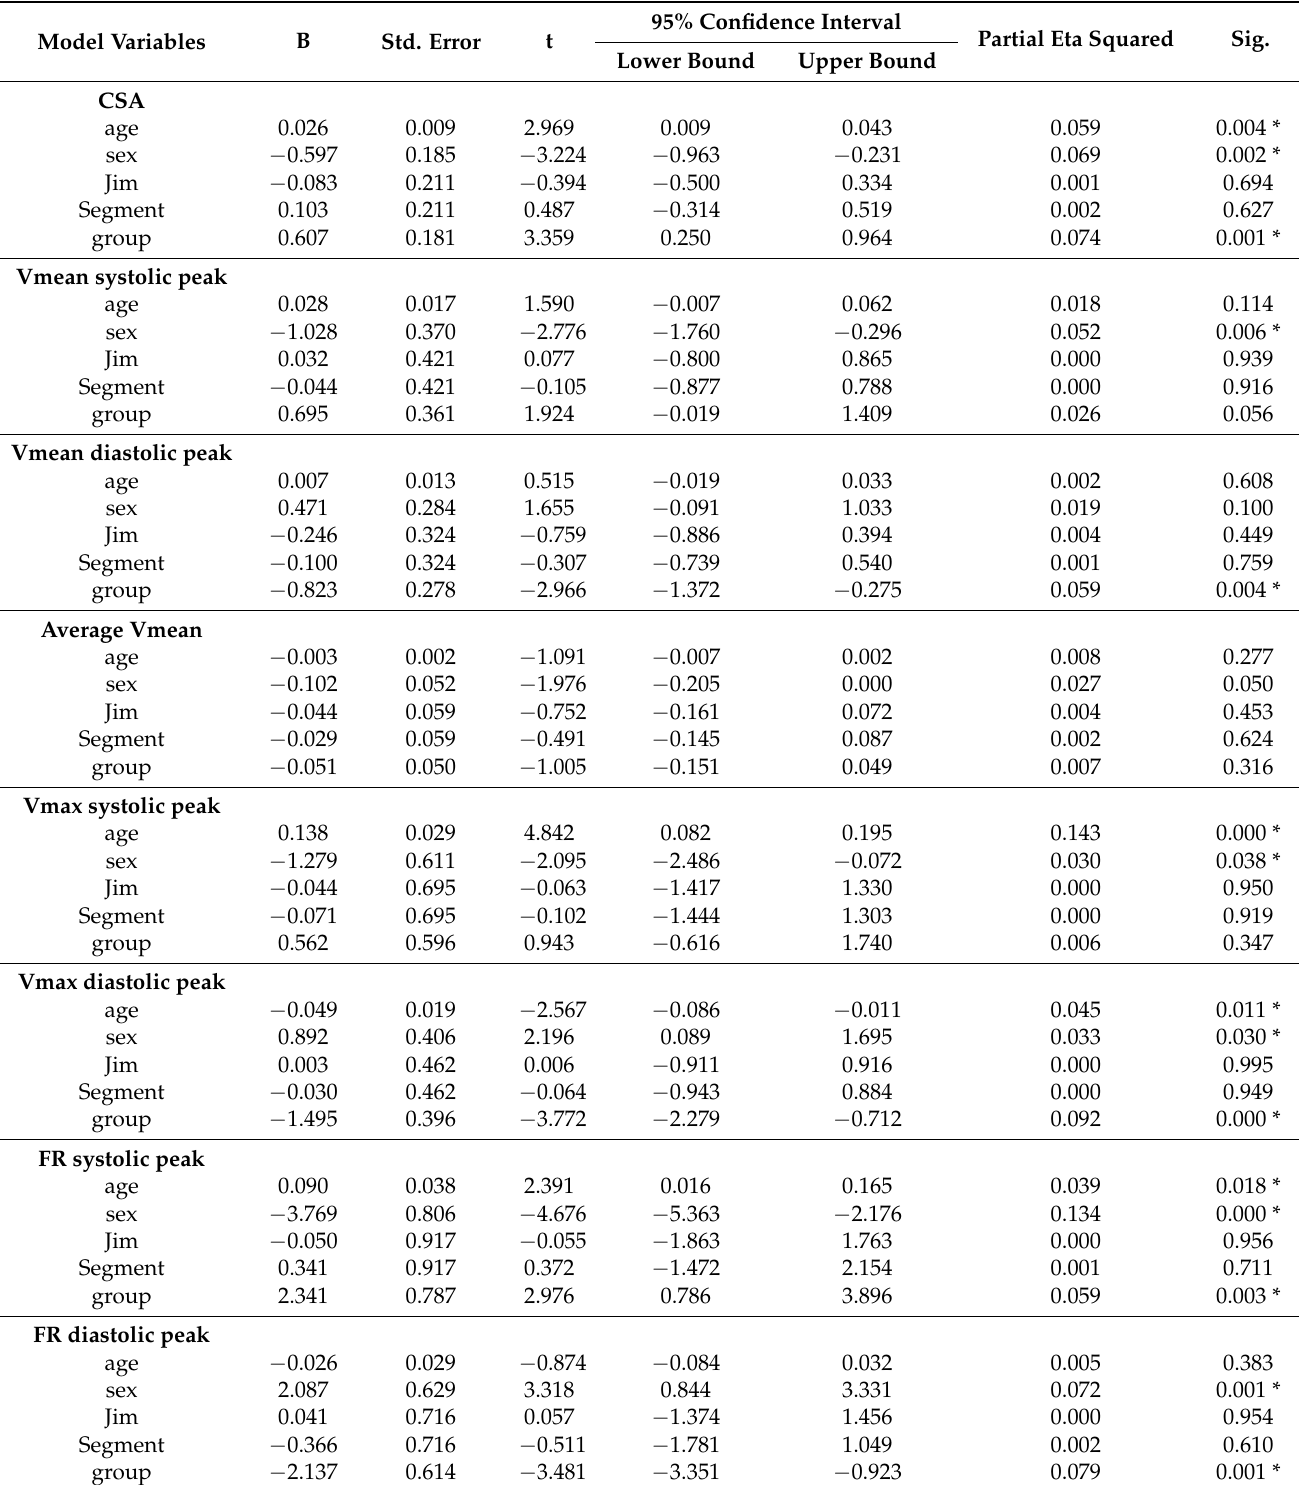
Table 3. Parameter estimates of the GLM